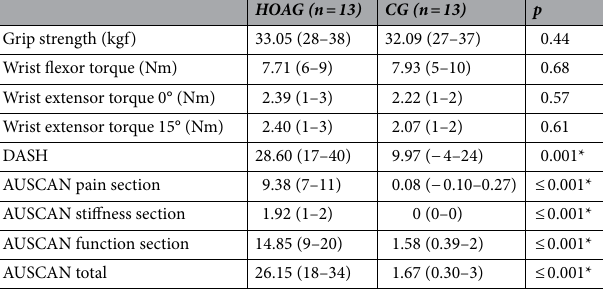
Table 2. Force values and questionnaires. *Significant